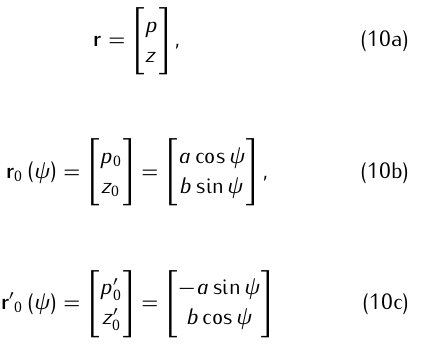
Algorithm A1 – “latitude” equation in terms of parametric (re- duced) latitude ( ξ = ψ )